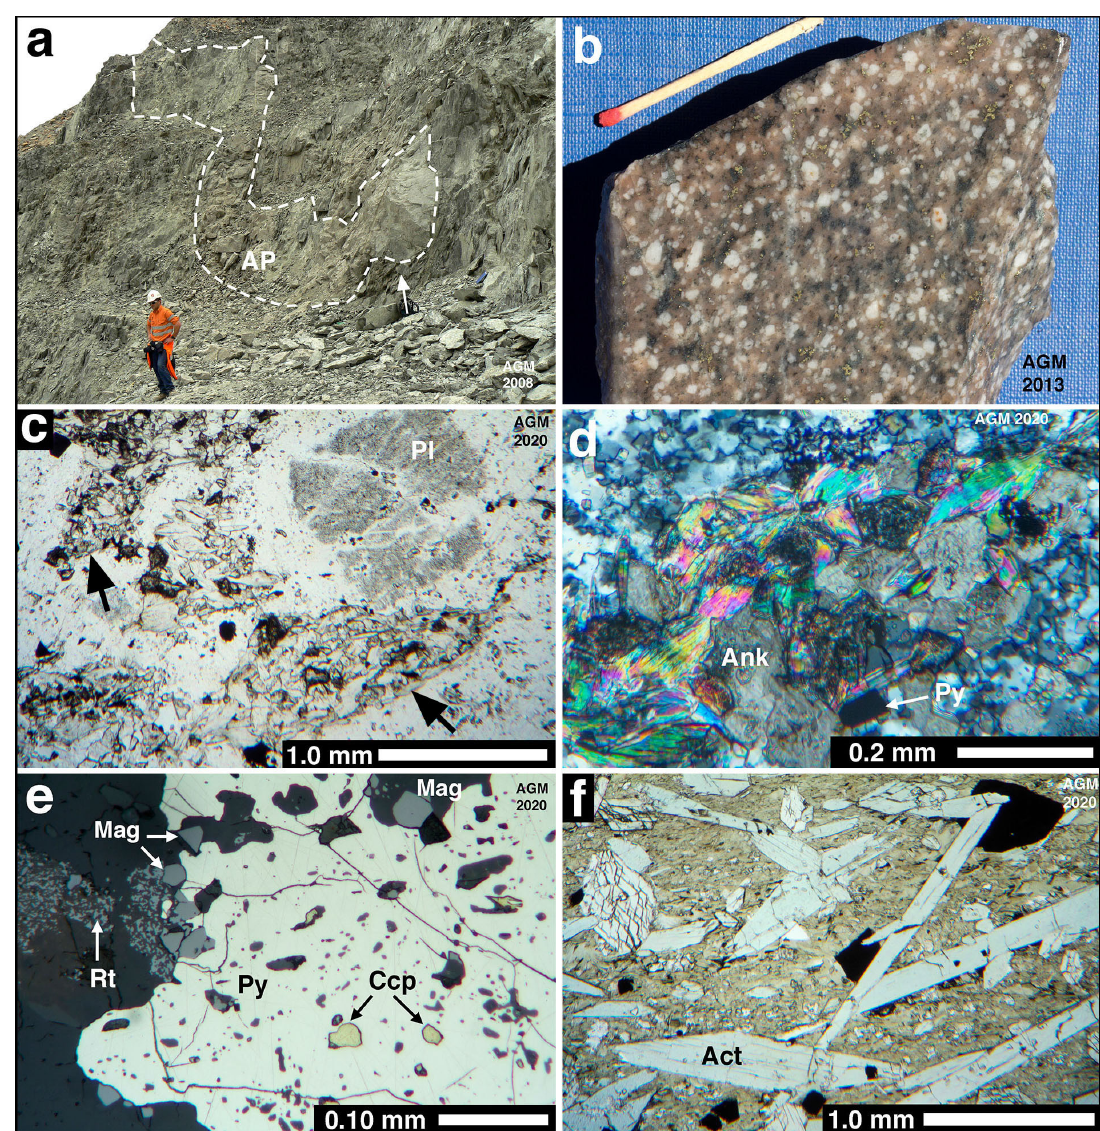
Figure 7. Photographs and photomicrographs of the Albite-Actinolite Porphyry: NE-wall of the open pit at +267 m, samples HB-3 ( a – e ; porphyry) and HB-2 ( f ; contact selvage). ( a ) Looking north at a section sub-parallel to strike through the porphyry dyke (AP; dashed line), the intrusive contact cuts across the foliation (arrow) in ultramafic schist. ( b ) White plagioclase phenocrysts in a pink albite-rich groundmass. Dark pseudomorphs after amphibole composed of ankerite, phengite, talc, pyrite (2 vol.%), magnetite (2%), and titanite-rutile (0.5–1%). The matchstick is 43 mm long. ( c ) Fractured plagioclase glomerocryst (Pl) and ankerite-phengite ± talc ± titanite-rutile ± pyrite aggregates after amphibole (arrows). Plane polarized light. ( d ) Phengite + ankerite (Ank) ± talc ± titanite-rutile ± pyrite (Py) aggregate after amphibole. Crossed polarized light. ( e ) Pyrite (Py) with chalcopyrite inclusions (Ccp) in contact with magnetite (Mag) and rutile (Rt). Plane polarized light reflected in air. ( f ) Replacement in talc-dolomite-chlorite schist: post-kinematic actinolite (Act), opaque magnetite, and pyrite in a phlogopite ± dolomite matrix. Plane polarized light. While actinolite absent in the porphyry, actinolite-rich replacement about 5 cm wide marks the intrusive contact. Actinolite needles (0.5–5 mm; 35–50 vol.%) are randomly oriented in a matrix of phlogopite (10–40%), dolomite ± calcite (15–40%), and accessory Mg-rich chlorite (Figure 7f). The actinolite is in mutual contact with pyrite (1–5%), rare chalcopyrite (0.5%), and zoned magnetite (1–2%). On the pit floor at +224 m, the Albite-Actinolite Porphyry was blasted and dismem- bered into boulders up to 2 m long. Felted actinolite needles formed a